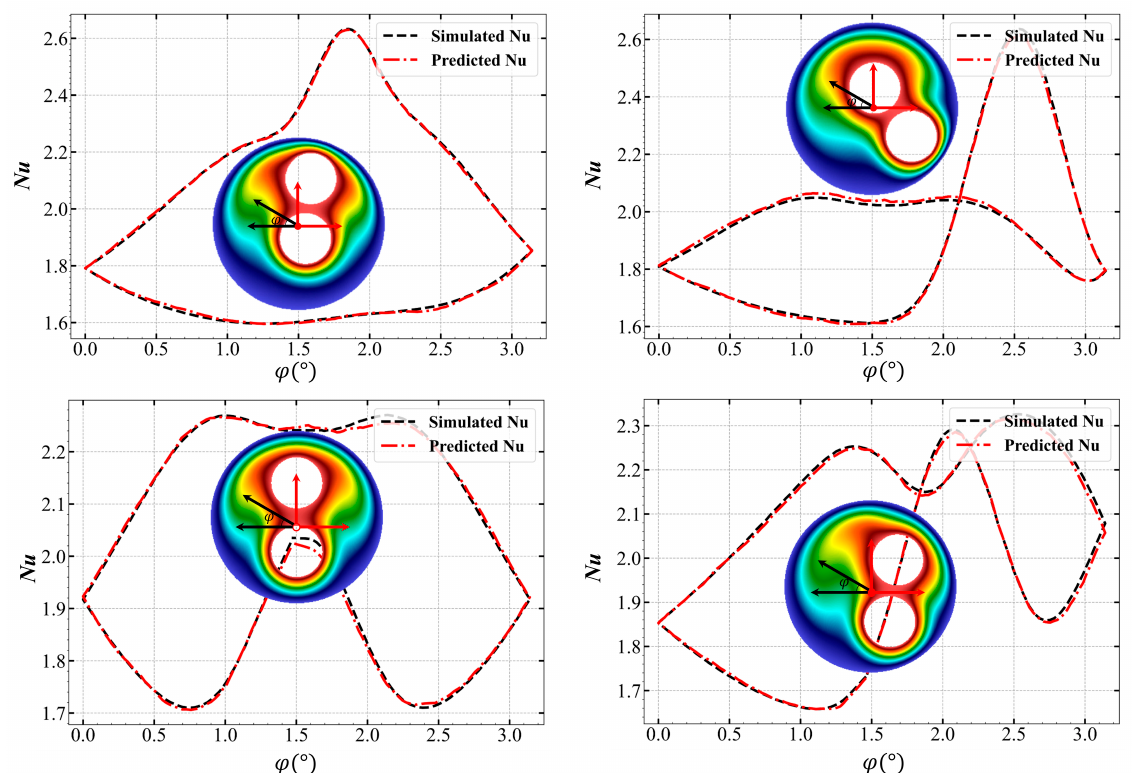
Figure 7. Nusselt number predictions of four representative double inner-cylinder annulus with various inner